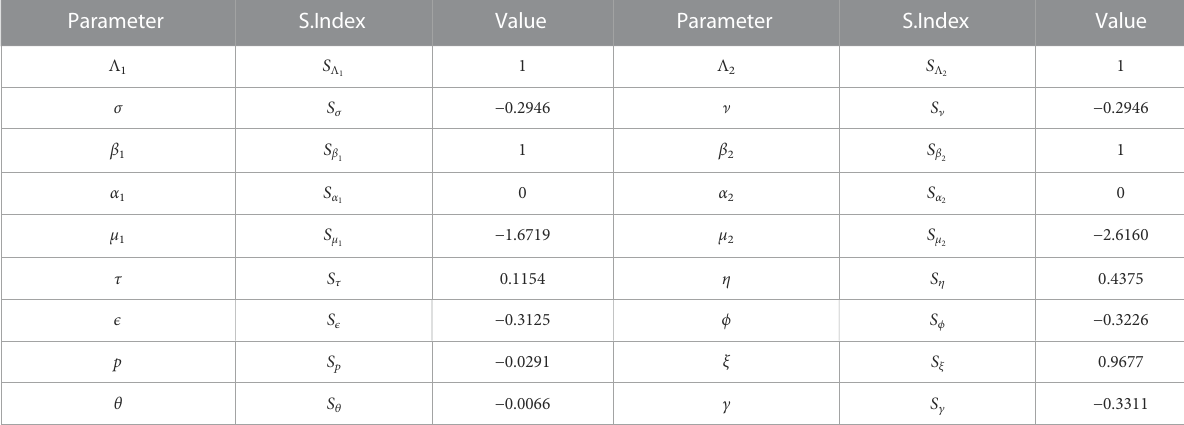
TABLE 1 Sensitivity indices of the basic reproduction number R 0 against mentioned